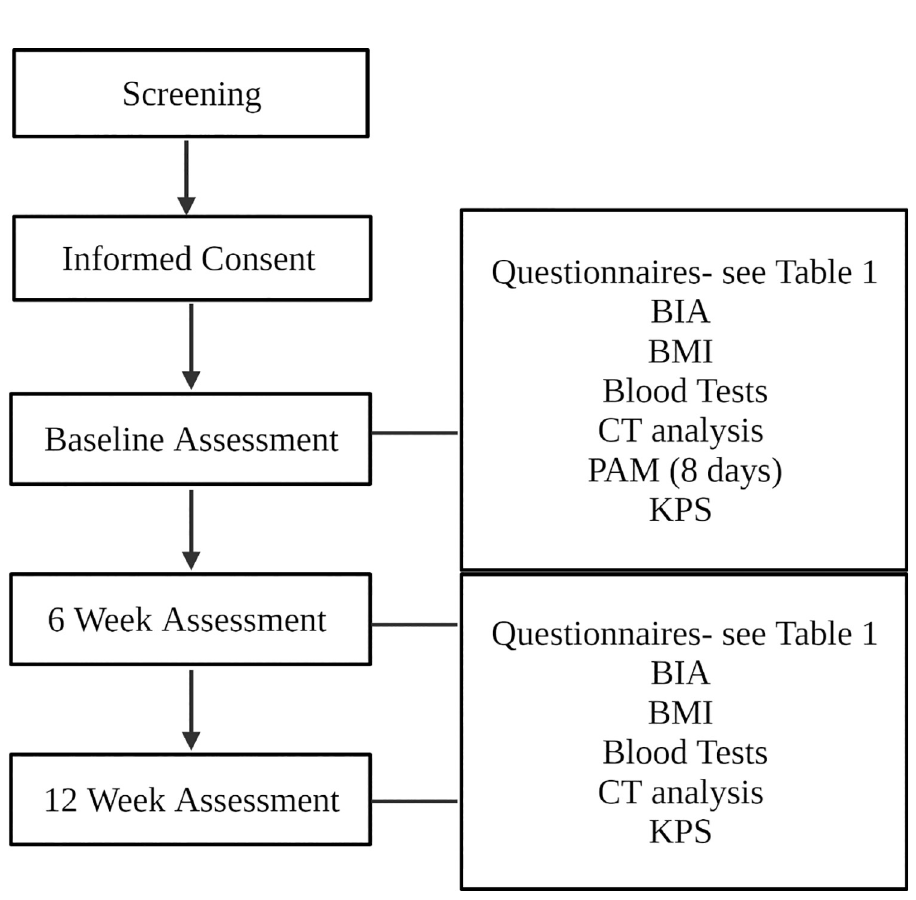
Fig 1. REVOLUTION study